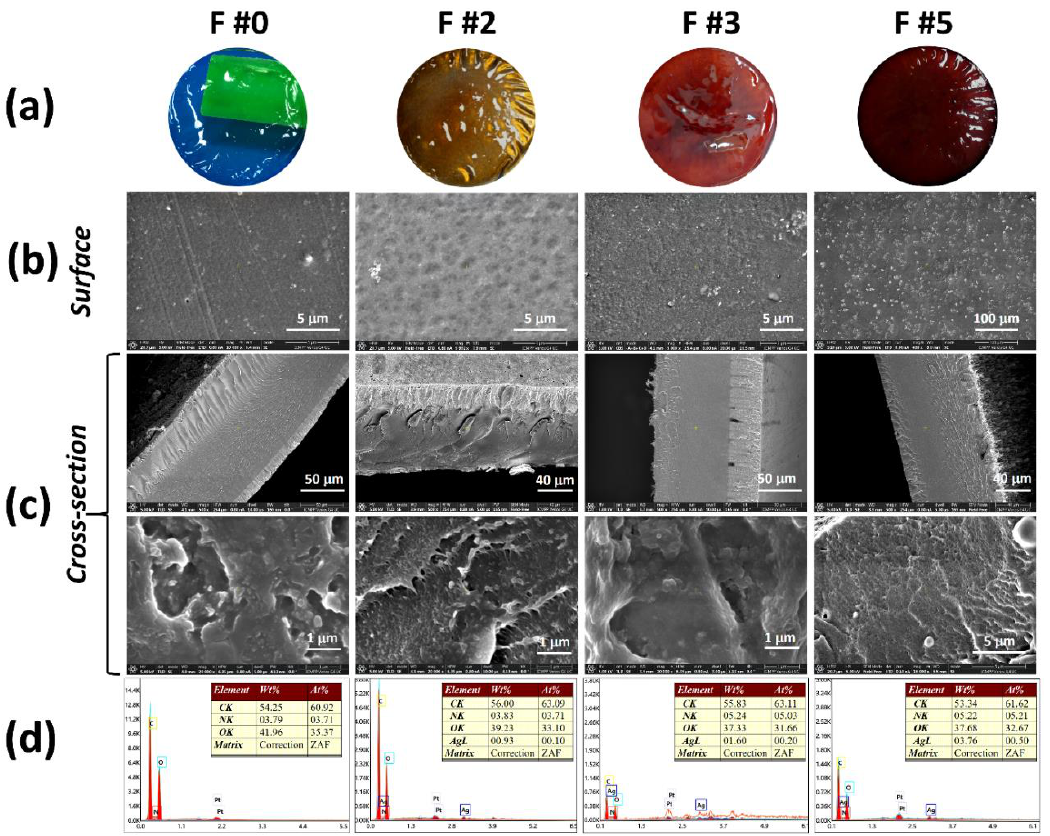
Figure 5. Optical images ( a ), SEM microphotographs of surface ( b ) and cross-section ( c ), and En- ergy-dispersive X-ray spectroscopy (EDX) spectra ( d ) of PVA/OxCS and composite PVA/OxCS-Ag